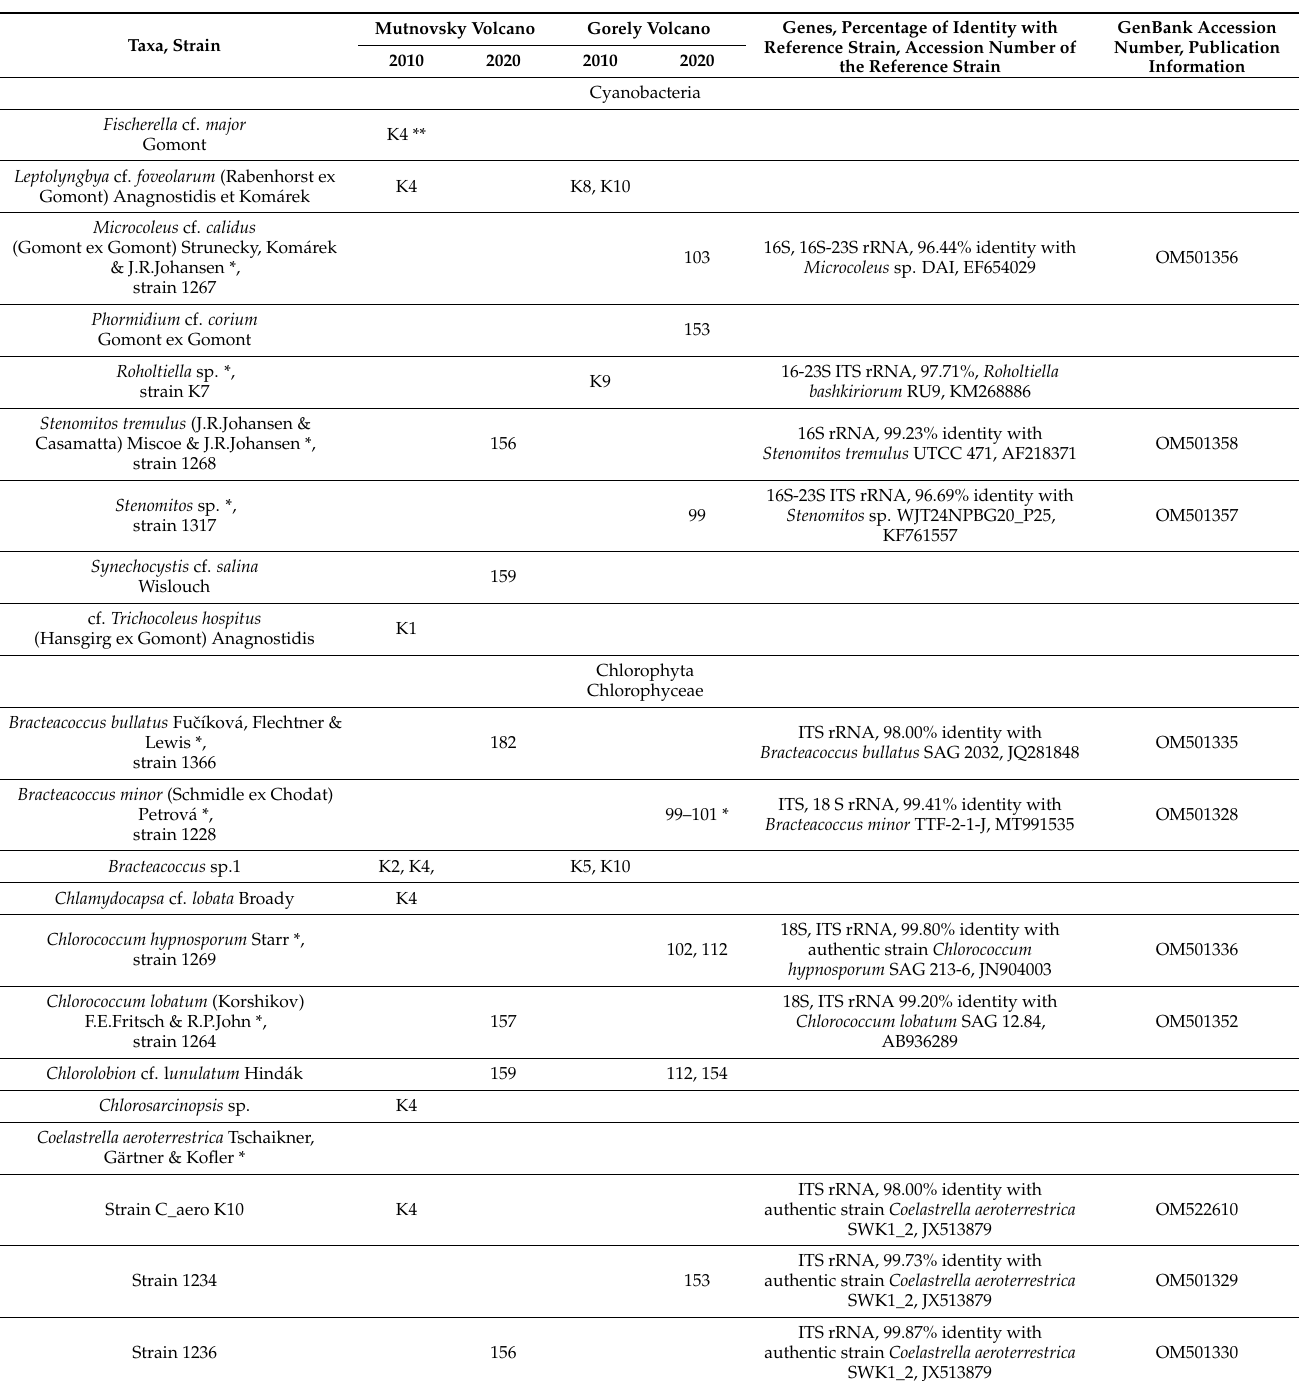
Table 2. List of algae and cyanobacteria in Mutnovsky and Gorely volcano soils. Mutnovsky Volcano Gorely Volcano Genes, Percentage of Identity with Taxa, Strain Reference Strain, Accession Number of the Reference